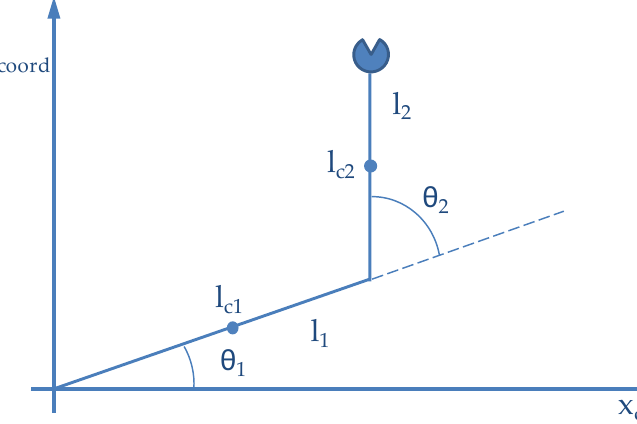
Figure 7. Planar manipulator with two revolute joints.